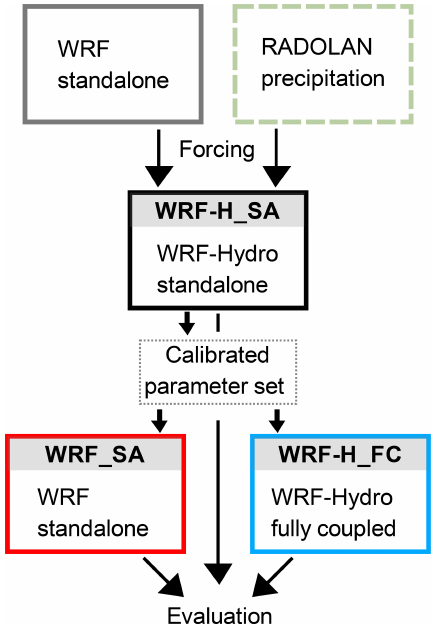
Figure 2. Modeling components and workflow. RADOLAN-RW is an hourly precipitation observation product of the German Weather Service with 1km 2 grid resolution.